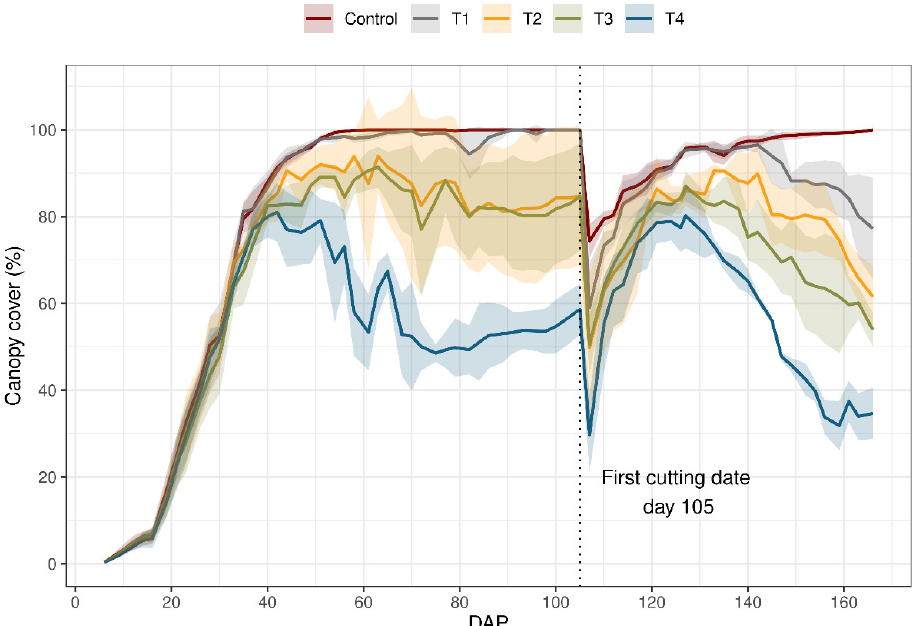
Figure 2. Canopy cover (cc) of ryegrass ( Lolium perenne ) during the growing season under different irrigation treatments. Control: non-stressed treatment; T1: moderate–low water stress treatment; T2: moderate–high water stress treatment; T3: medium intensity severe water stress treatment; T4: high intensity severe water stress treatment. The first cutting was made day 105. Solid line connects cc means and shadow area shows standard deviation from the mean values.